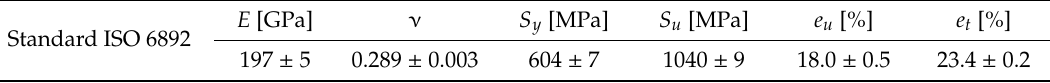
Table 4. Uniaxial mechanical properties of Gen3 980T steel.